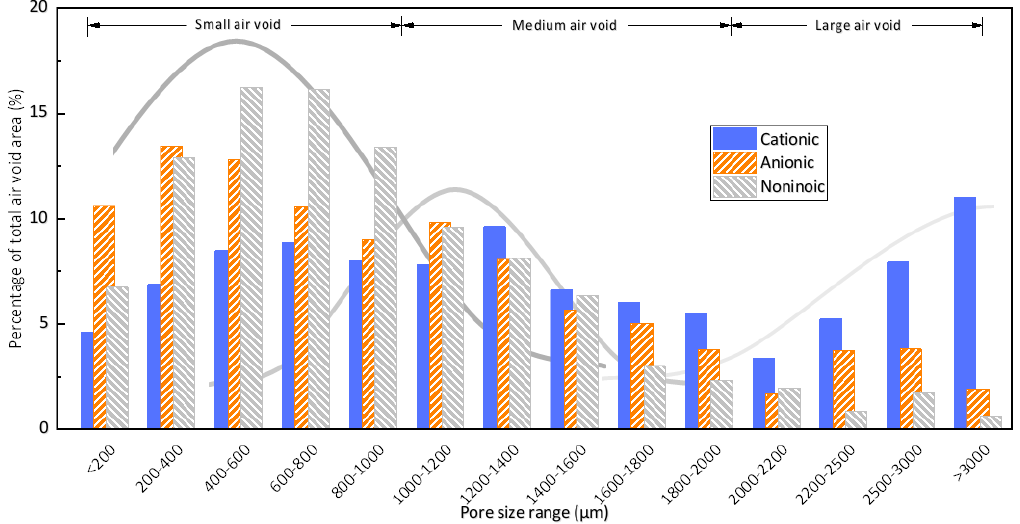
Figure 4. Air void size distribution of hardened mortars with different surfactants.